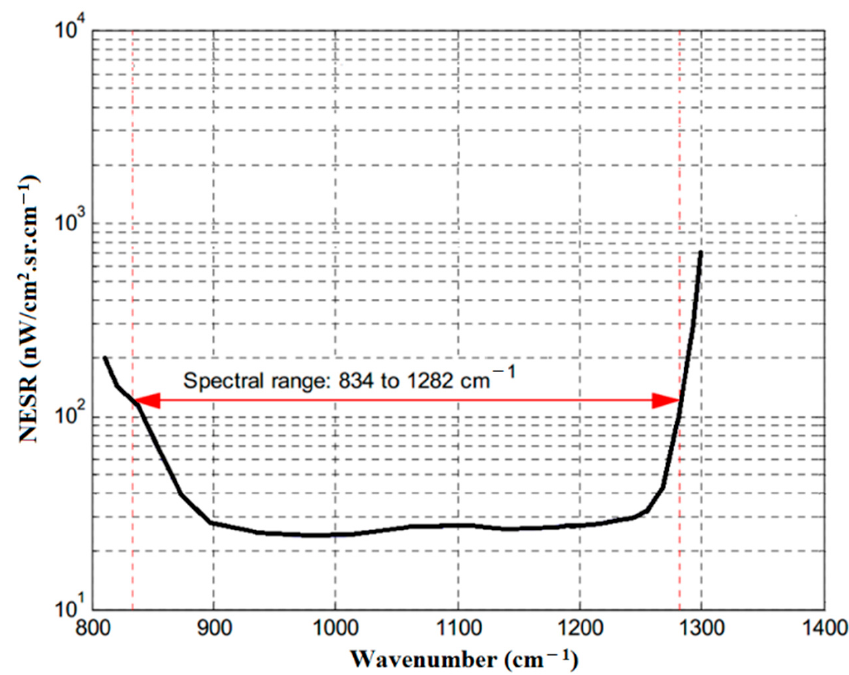
Figure 2. Spectral NESR measurement, averaged for all the good pixels. Table 2. Technical parameters of Hyper-CAM.